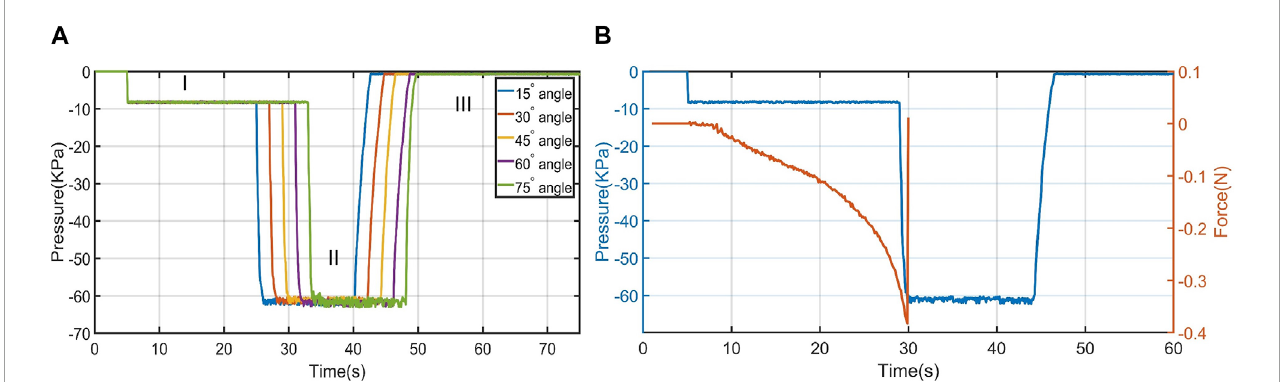
FIGURE 6 (A) The recorded pressure during the adaptation test for various angles (I) the initial pressure due to the self jamming of the granular particle during the adaptation (II) The pressure after the surface attachment (III) the pressure after detachment. (B) The pressure against the adaptation force at 45° surface angle. The force is only recorded until the suction cup attached to the surface, since after the attachment the tensile tester records the force for lifting the substrate.